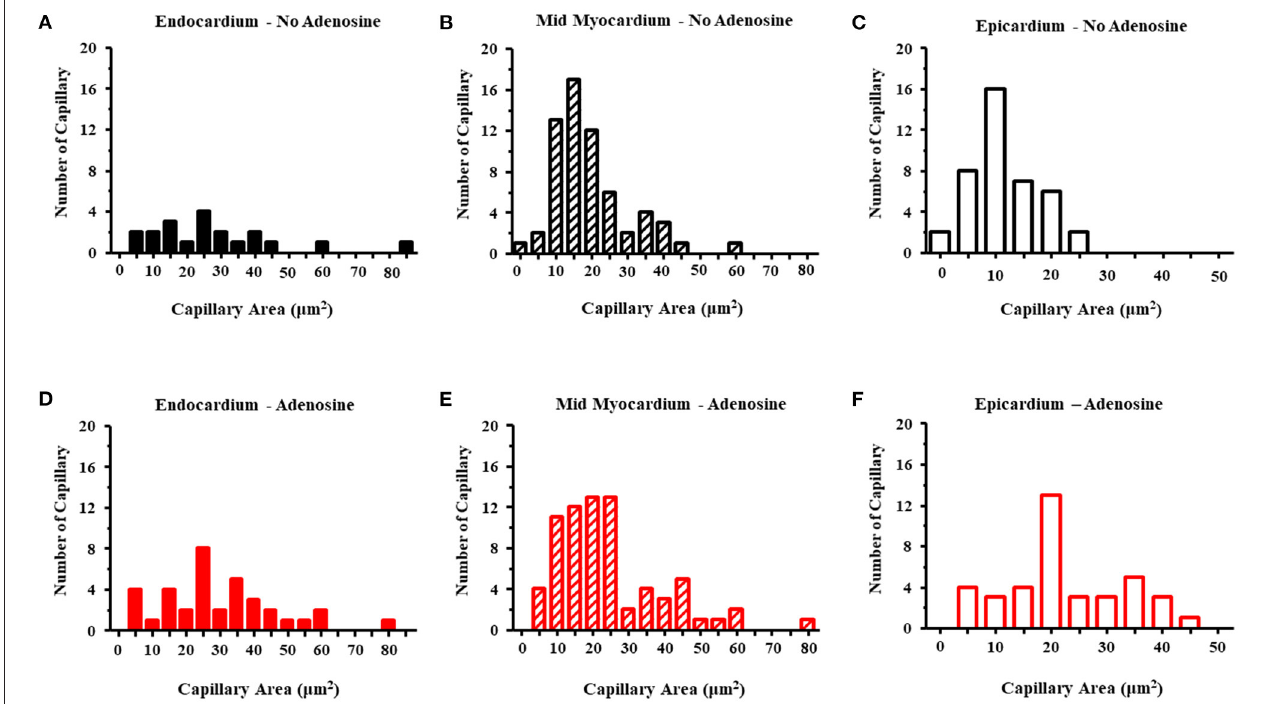
FIGURE 3 | Histograms of the capillary area without adenosine in the endocardium (A) , mid-myocardium (B) , and epicardium (C) and with adenosine in the endocardium (D) , mid-myocardium (E) , and epicardium (F) . The capillary sizes are depicted on the x-axis in increments 5 µ m 2 . The frequency of capillary measurements is depicted on the